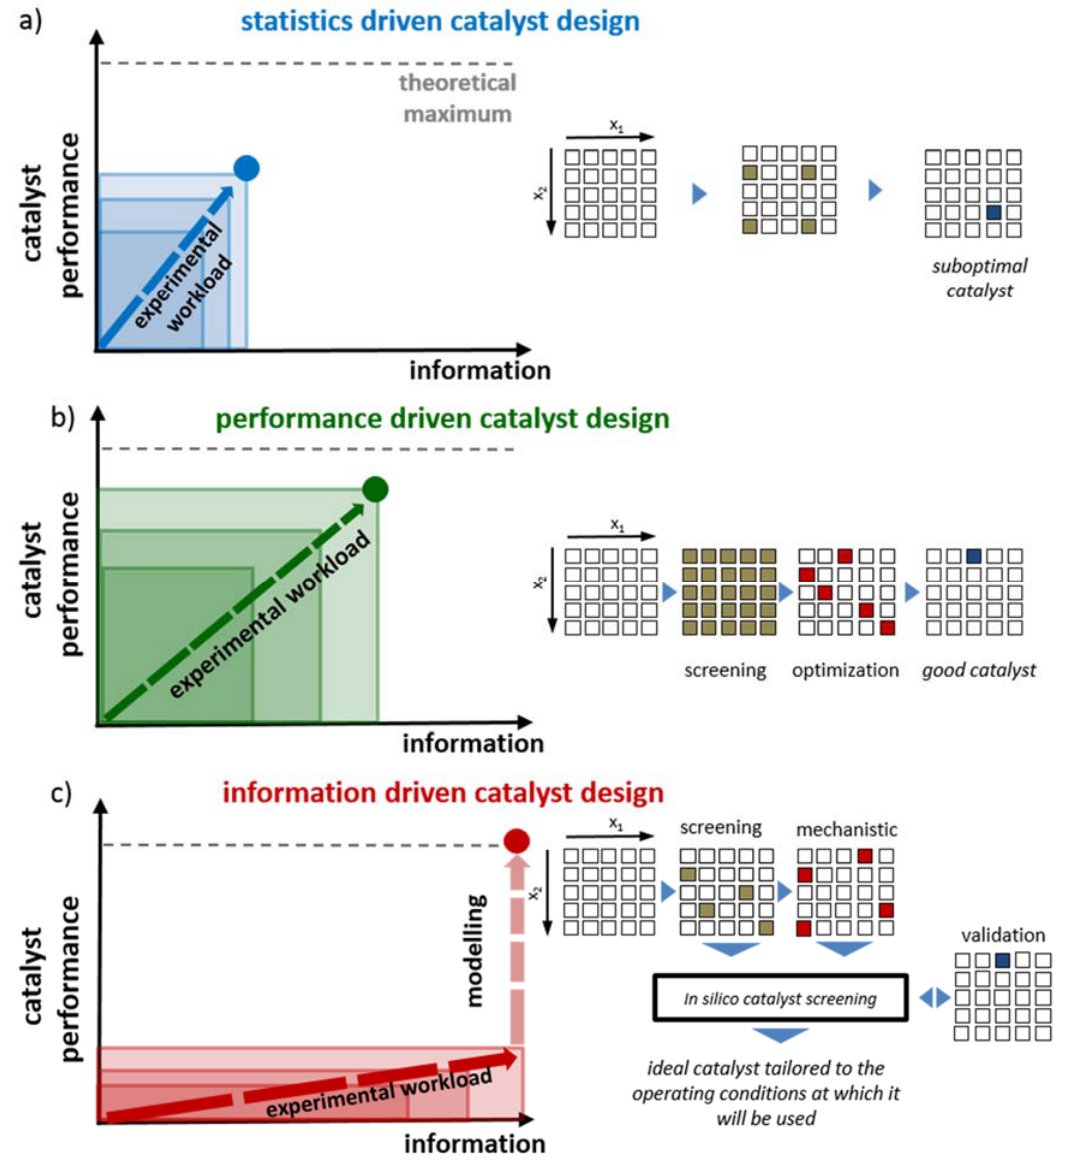
Figure 1. Different methodologies in catalyst design: ( a ) statistics-driven catalyst design; ( b ) performance-driven catalyst design; and ( c ) information-driven catalyst design. Catalyst performance is plotted on the y -axis and mechanistic information on the x -axis. The